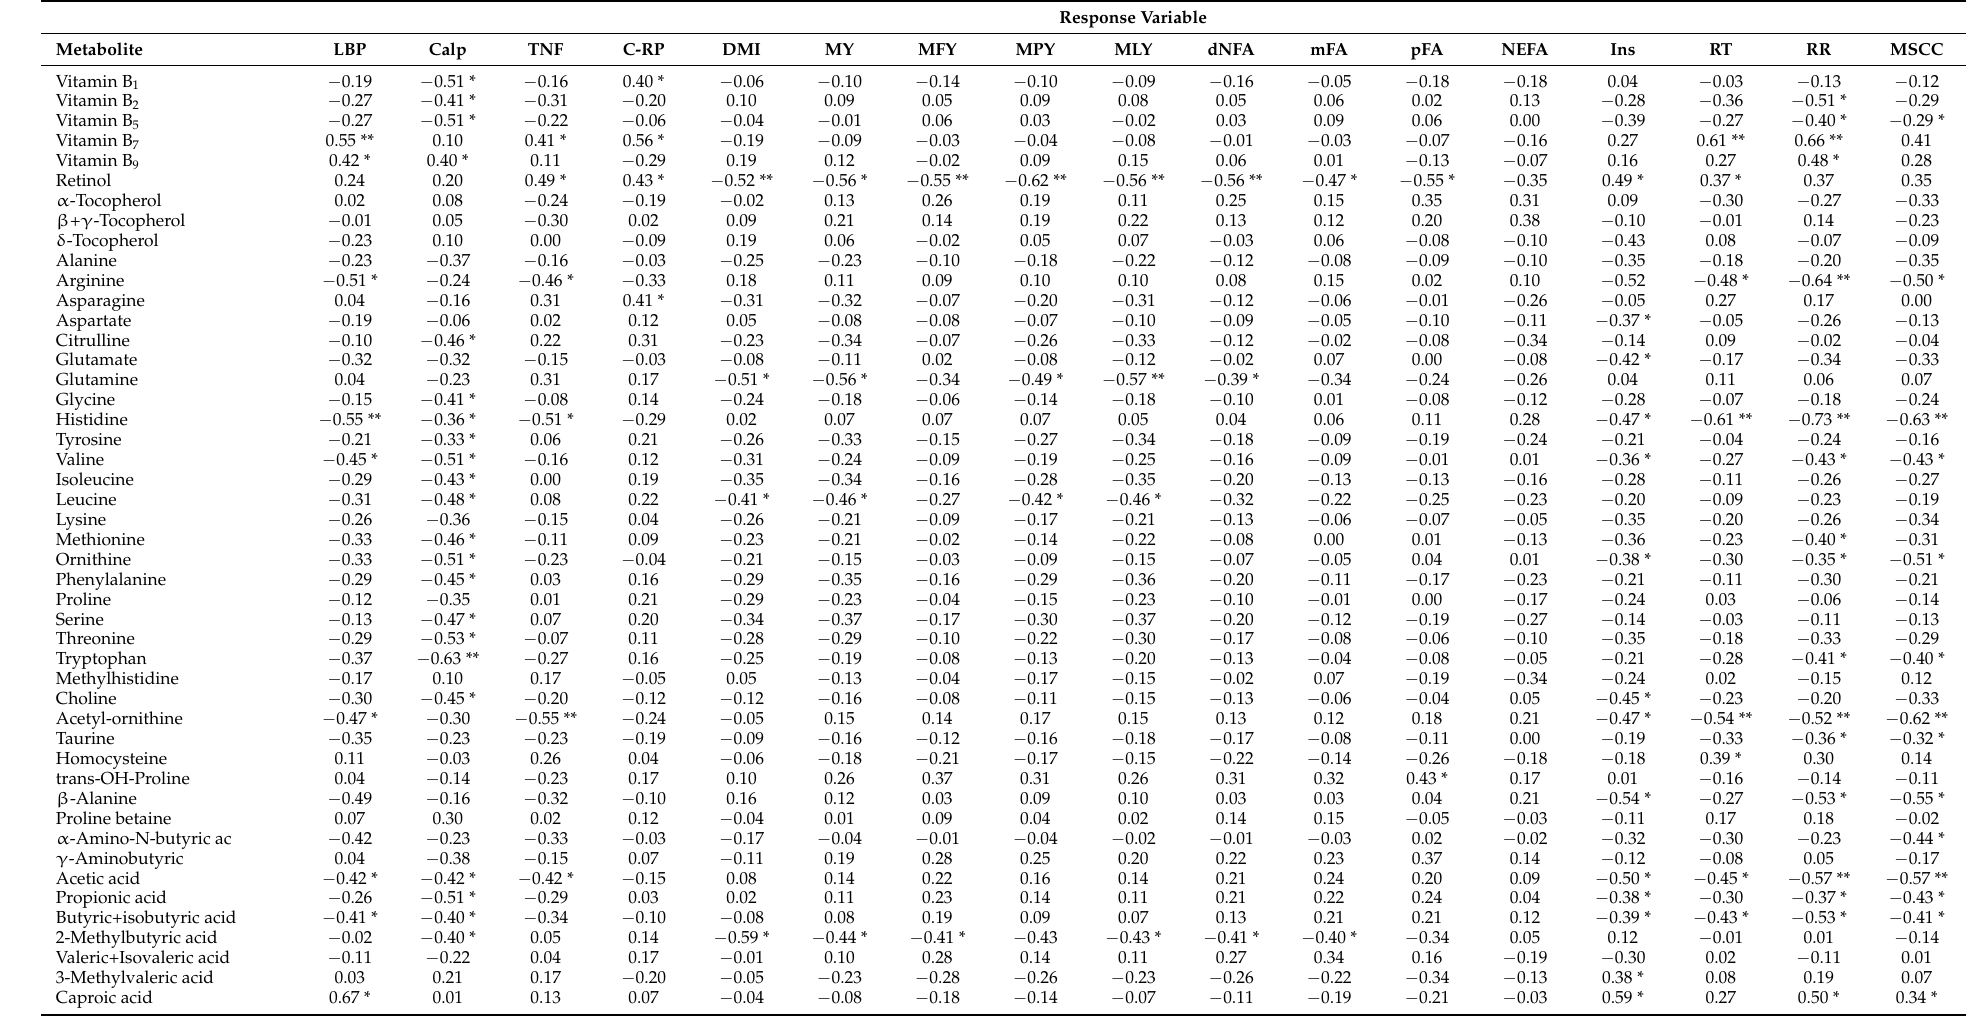
Table 3. Partial Pearson’s correlation between fecal metabolite concentrations and indicators of inflammation, heat stress, metabolism, and performance across treatments